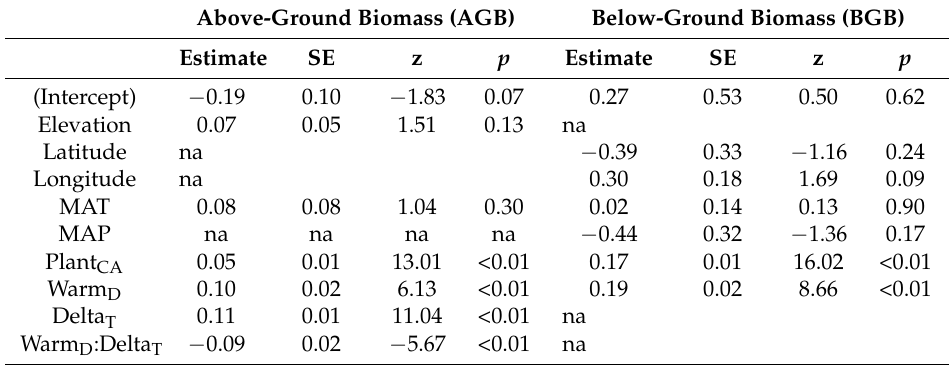
Table 1. Model-averaged coefficients, standard errors (SE), z-tests, and p -values for parameters which were included within the final (best) model sets for above-ground biomass (AGB) and below-ground biomass (BGB).